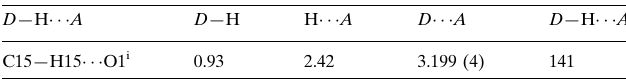
Hydrogen-bond geometry (A˚ , (cid:1)